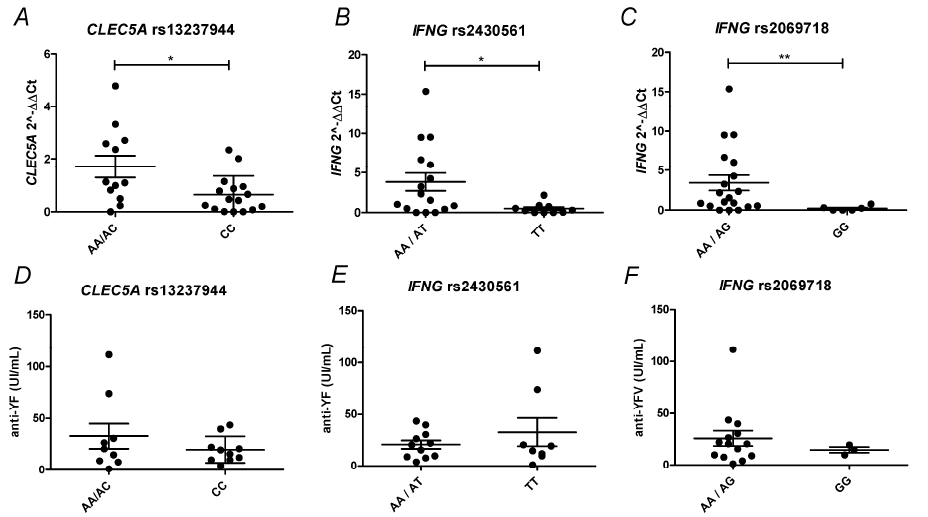
Figure 3. CLEC5A and IFNG SNPs associated with YF17DD immunologic responses. ( A – C ) Relative expression of CLEC5A and IFNG at 7 DAV according to SNP genotyping. The expression of CLEC5A and IFNG was stratified according to ( A ) rs13237944, ( B ) rs2430561, and ( C ) rs2069718 genotypes (n = 38). ( D – F ) Anti-YF antibody production according to SNP genotyping. Anti-YF antibody production at 60 DAV was stratified according to ( A ) rs13237944, ( B ) rs2430561, and ( C ) rs2069718 genotypes ( n = 19). Each dot corresponds to one individual analyzed, with median and standard error of groups. Statistical analysis was determined using Mann–Whitney test. p value is represented as * p < 0.05, ** p < 0.01. DAV: days after vaccination.